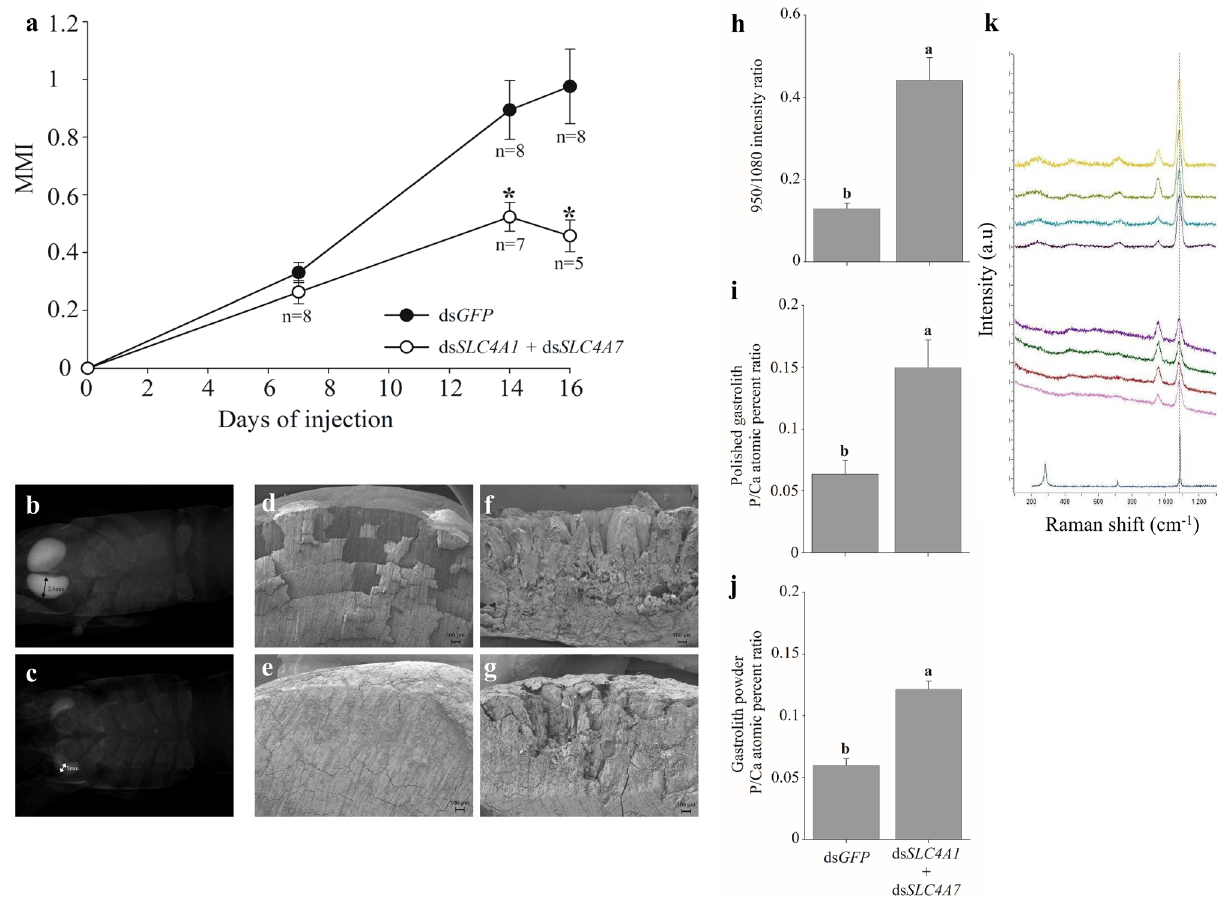
Figure 3. Effects on gastrolith mineralization following loss-of-function of CqSLC4 through RNAi. ( a ) The mineralization of the gastroliths is shown in terms of the molt mineralization index (MMI) of animals in the control group injected with ds GFP (n = 8) and of animals in the treatment group injected with ds SLC4A1 + ds SLC4A7 (n = 8, day 7), (n = 7, day 14) and (n = 5, day 16). Data are means ± s.d. Asterisk (*) represents statistically significant difference (p-value < 0.05) between the ds GFP and ds SLC4A1 + ds SLC4A7 at the same time point. ( b,c ) Representative X-ray images of gastroliths of: ( b ) ds GFP -injected control crayfish and ( c ) silenced crayfish injected with ds SLC4A1 + ds SLC4A7 . ( d–g ) Representative SEM images of gastrolith cross sections of: ( d,e ) control crayfishes and ( f,g ) silenced crayfishes. Phosphate to calcium ratio in the gastroliths of the treatment group injected with ds SLC4A1 + ds SLC4A7 versus the control group injected with ds GFP is shown using various techniques. ( h ) Ratio of the intensities of the Raman peaks at 950 and 1080 cm-1 for control (n = 8) versus treatment animals (n = 8). ( i ) Ratio between the atomic percentages of phosphate and calcium in a polished gastrolith (cross section) of a control animal (n = 8) versus a silenced animal (n = 8). ( j ) EDXS-derived ratio of the atomic percentages of phosphate and calcium of gastrolith powder from control (n = 8) versus silenced animals (n = 8). For all graphs different letters represent groups that are significantly different (p < 0.05); bars represent standard error. ( k ) Representative Raman spectrum with peaks at 950 and 1080 cm −1 , indicating the presence of amorphous calcium phosphate and amorphous calcium carbonate, respectively. The four traces at the top of the figure are those for a gastrolith of a representative control animal; the four traces in the middle of the figure relate to a gastrolith of a representative treatment animal; and the bottom trace is that for pure calcite as a